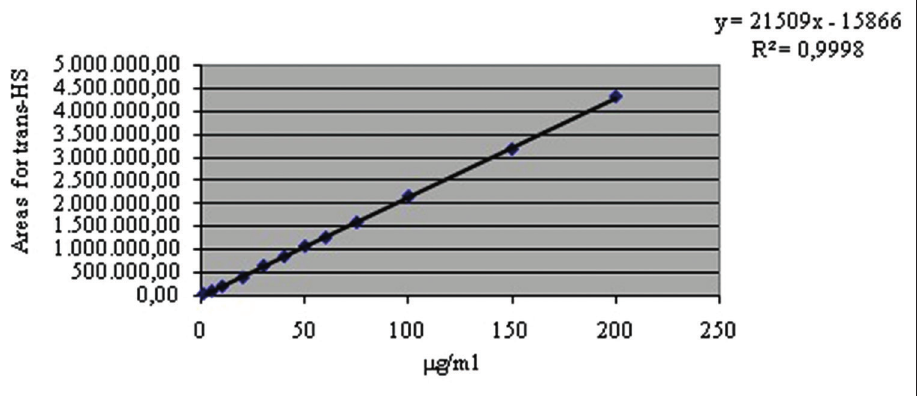
FIGURE 3. Calibration curve for homosalate. The linearity of the analytical method was tested through a concentration range of 1–200µg/mL of the homosalate standard. TABLE 5. Measured samples areas, calculated arithmetic mean, difference between areas, concentration, and recovery Samples